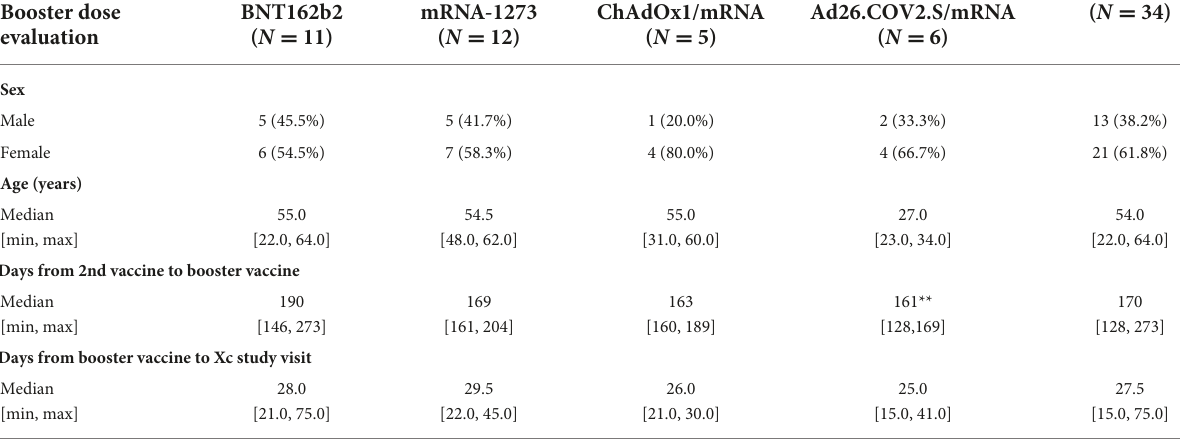
of ACE2 receptor blocking was also observed for SARS-CoV- 2 S-specific for B.1.1.7, B.1.617.2, and B.1.351 ( Supplementary Figures 1A,B ,